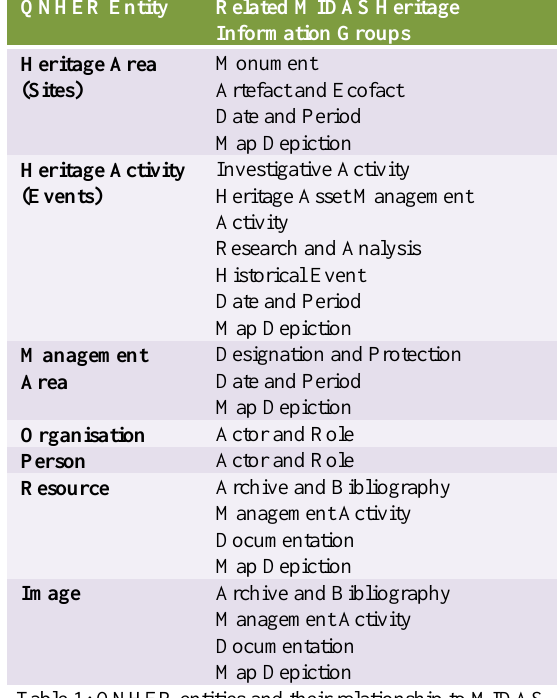
Table 1: QNHER entities and their relationship to